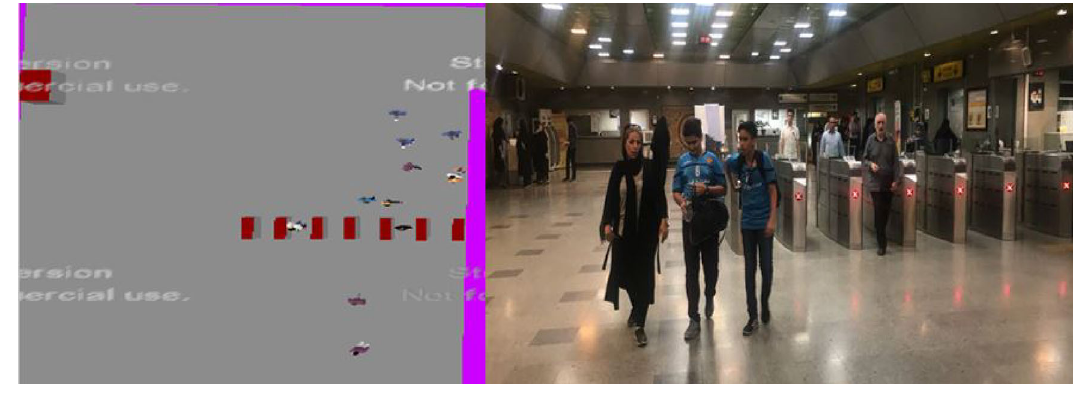
Fig. 3 Validation of ticket control section in Shohada Square station